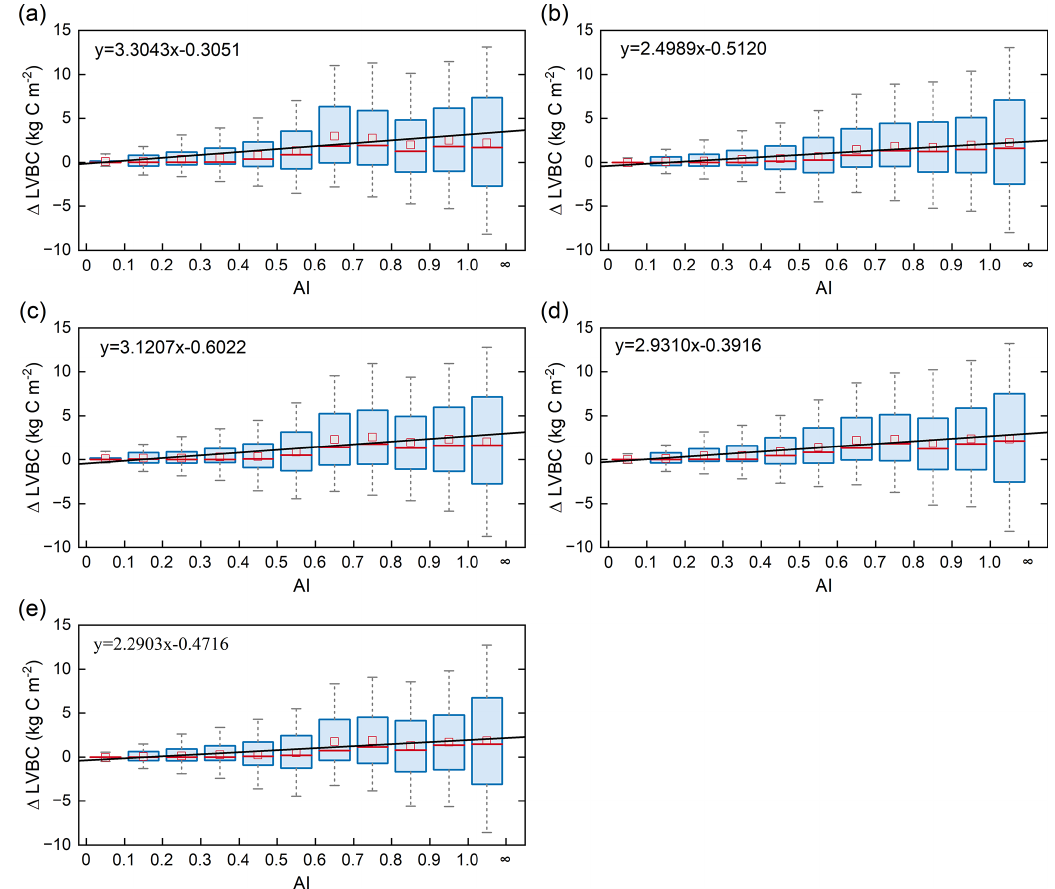
Figure 9. Relationships of the incremental change between AI and LVBC. Magnitude of change in LVBC in the historical scenario S1 (a) , CO 2 in scenario S2 (b) , CO 2 + precipitation in scenario S3 (c) , CO 2 + temperature in scenario S4 (d) , and CO 2 + radiation in scenario S5 (e) . The range of the box is 25%–75% of values, the range of the whiskers is 10%–90% of values, the small red square is average value, the red line is the median line, and the black line is the fitted curve. Positive value of the y axis represents the magnitude of increased LVBC from 1916 to 2015 under water-limited conditions, and vice versa. AI of grid cells is calculated by multiyear average precipitation and multiyear average potential evapotranspiration in the period of 1916–2015. Categories of hydrological zones include hyper-arid (AI ≤ 0.05), arid (0.05 < AI ≤ 0.2), semi-arid (0.2 < AI ≤ 0.5), sub-humid (0.5 < AI ≤ 0.65), and humid (AI >